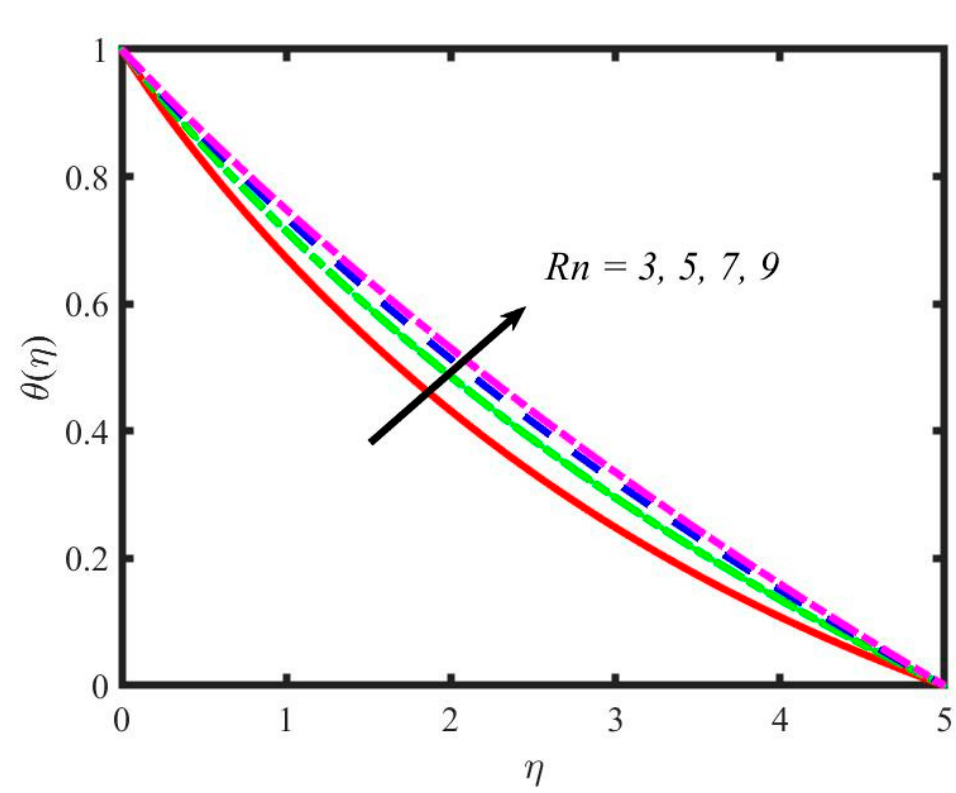
Figure 9. Variations in nanoparticle temperature for activation energy parameter.